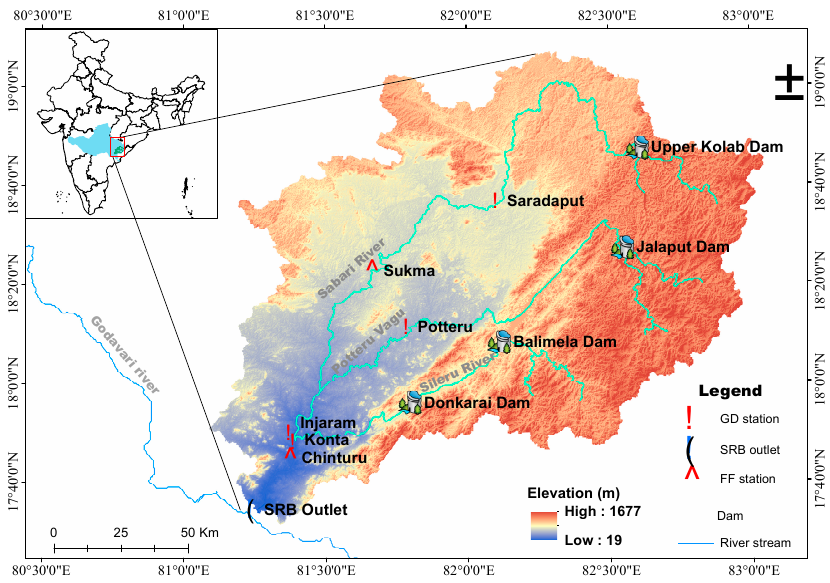
Figure 1. Map of the Sabari River Basin detailing major river streams, reservoirs, gauge-discharge (GD) and flood forecasting (FF) stations. Elevation of the basin shown from blue to red colour. Godavari River Basin is shown in a blue filled polygon on the India map.